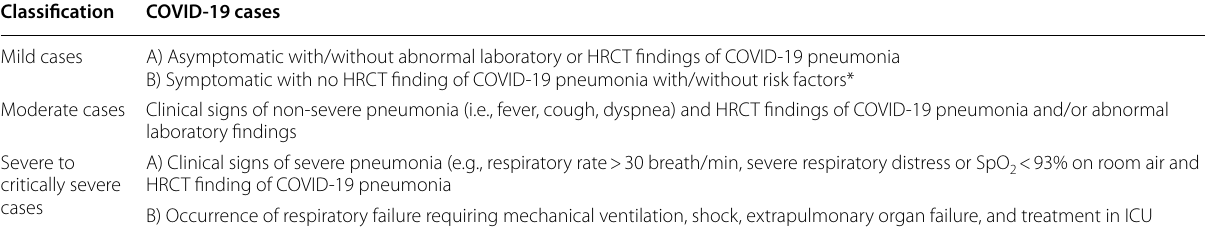
HRCT, High-Resolution Computed Tomography; ICU, intensive care unit. Risk factor*, age > 60 years, body mass index (BMI) > 40, pregnancy, comorbidities such as hypertension, diabetes, cardiovascular disease, chronic respiratory disease (asthma, chronic obstructive pulmonary disease (COPD)), chronic kidney disease, active malignancy or immunosuppressive disease or